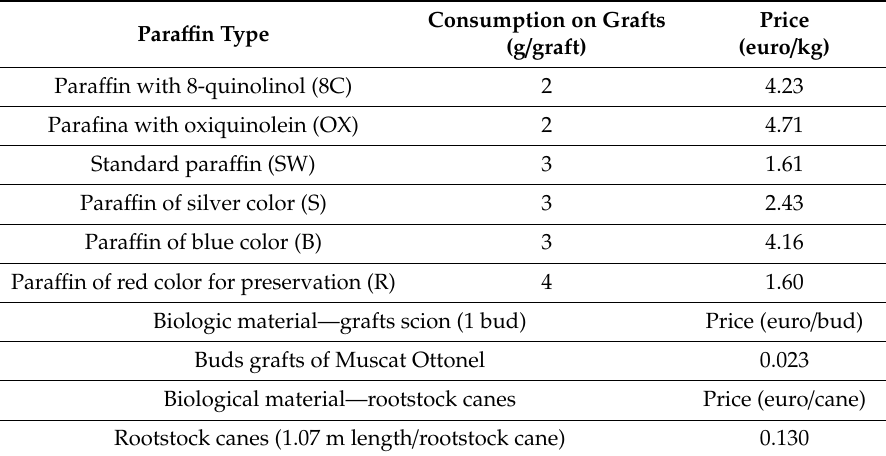
Table 3. Consumption on grafts, para ffi n and biological material